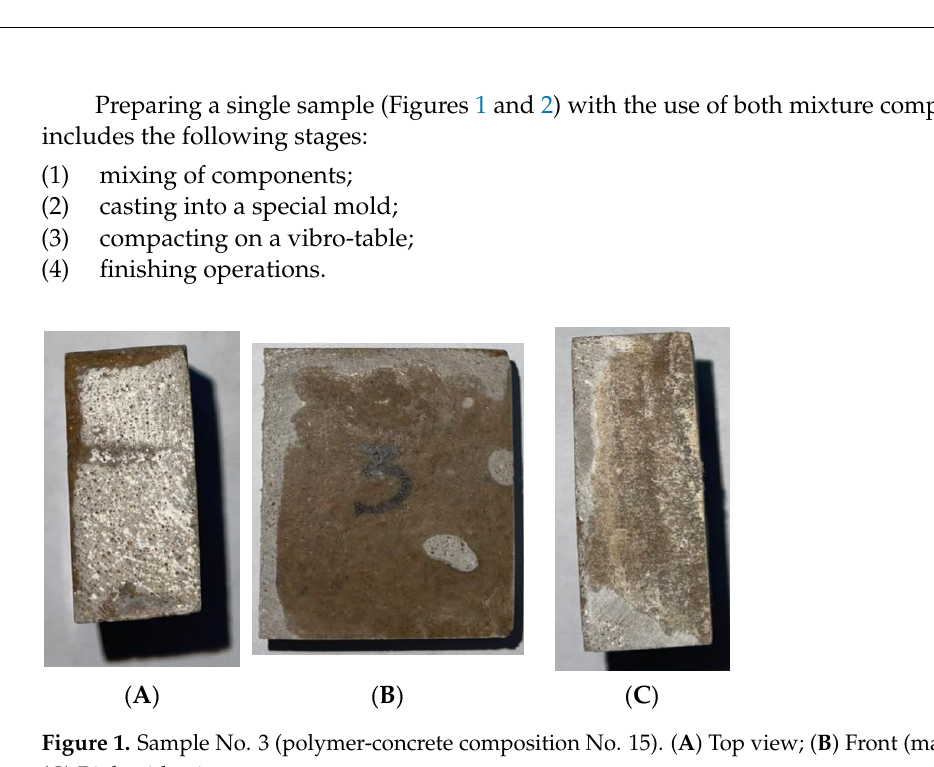
Table 2. Polymer-concrete composition No. 23.